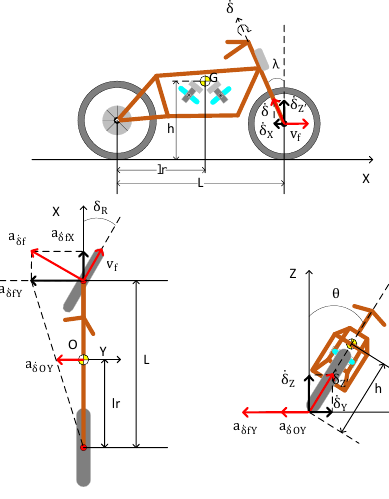
Figure 6. Three views of the motorcycle.